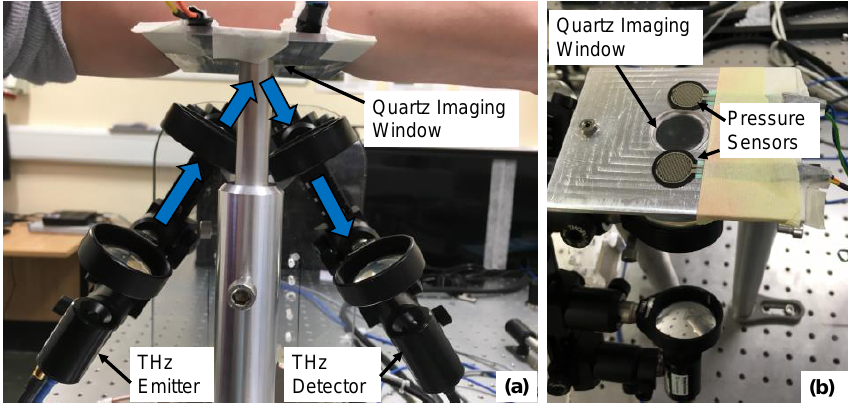
Figure 2. The experimental setup used to take THz measurements of the skin with a reflection geometry, from the front ( a ) showing the THz emitter/detector and from above ( b ) showing the pressure sensors positioned either side of the quartz imaging window.